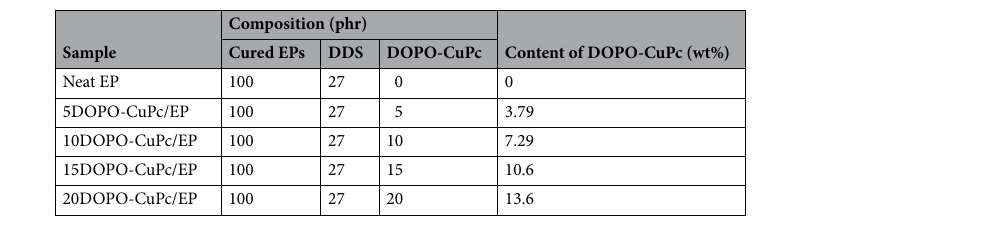
Table 1. Formulations of epoxy